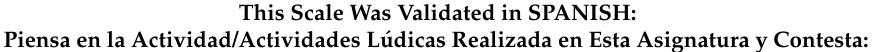
Table A1. Cuestionario sobre la Motivaci ó n por las Estrategias L ú dicas de Aprendizaje Cooperati- vas (CMELAC).